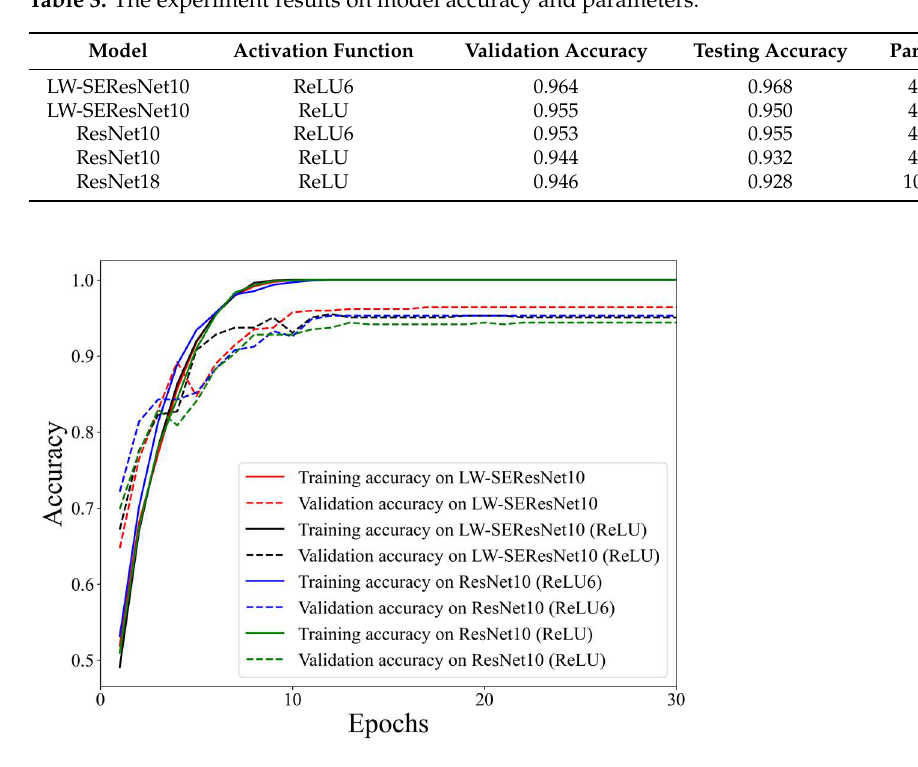
Figure 6. The training process of four models.